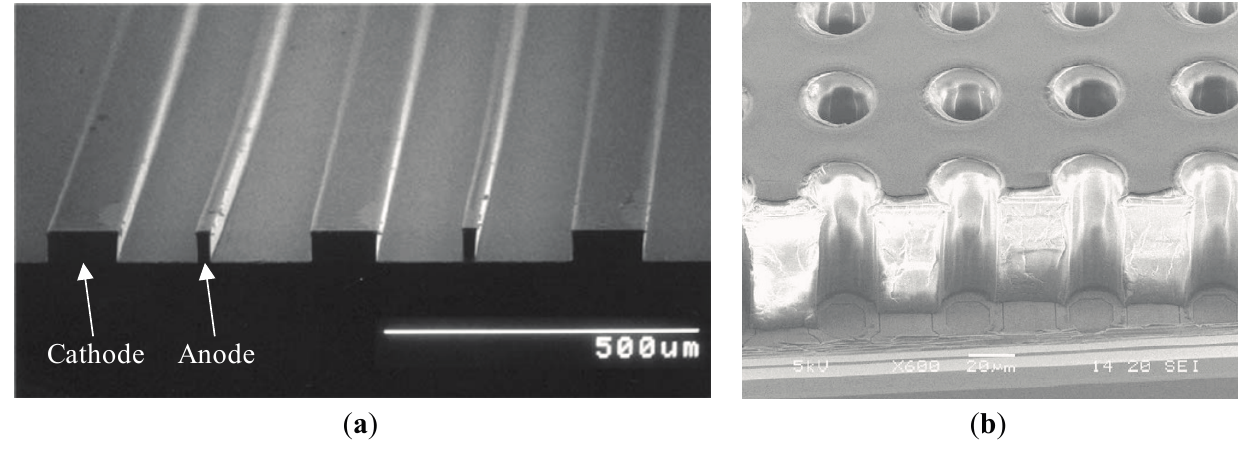
Figure 2. ( a ) Scanning electron microscope (SEM) image of basic non-planar microstrip gaseous detectors (MSGD) structure on a glass substrate, sectioned with a wafer saw. Alternated gold anode and cathode electrodes are patterned on top of 50 µm thick SU-8 strips. Adapted from [8], with permission. ( b ) SEM image of a microwell structure consisting in a 55 µm thick SU-8 layer defining the microwells, with an aluminium top cathode, patterned over a Timepix CMOS chip. Reprinted from [9], © 2004 Elsevier.